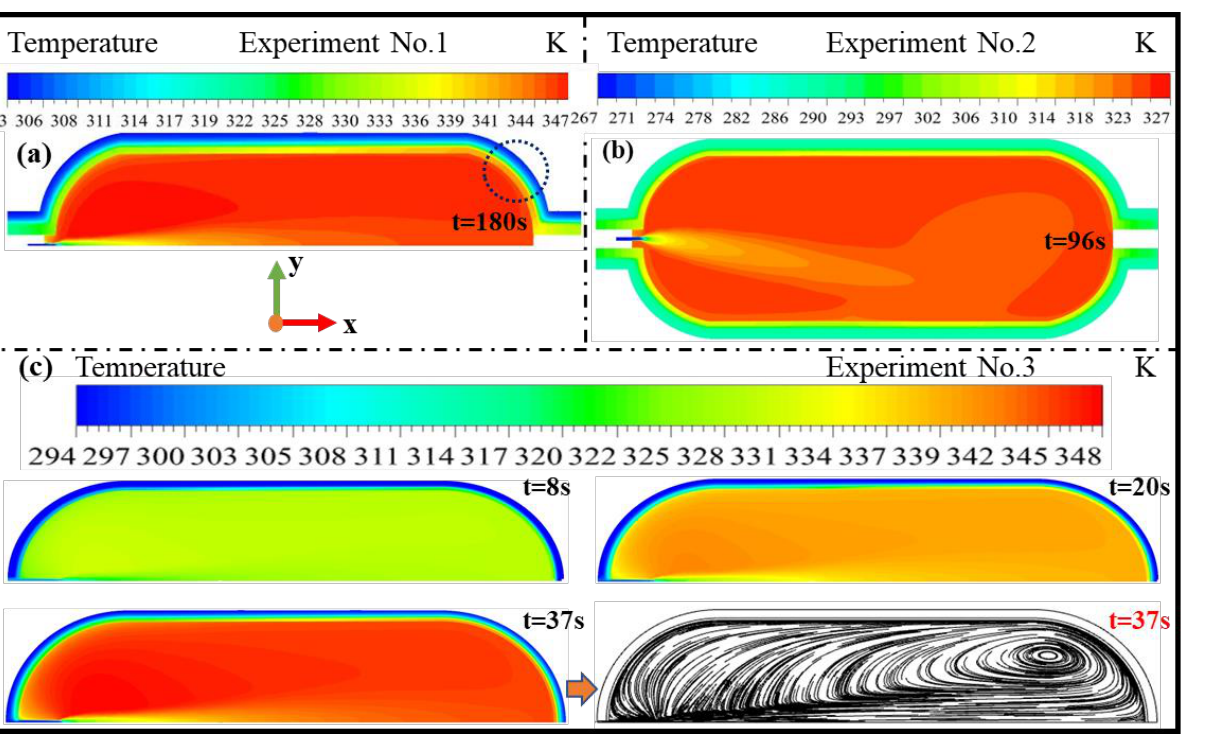
Figure 6. Predicted temperature distributions within the cylinder in Experiment No. 1 ( a ), No. 2 ( b ) and No. 3 ( c ). and No. 3 ( c